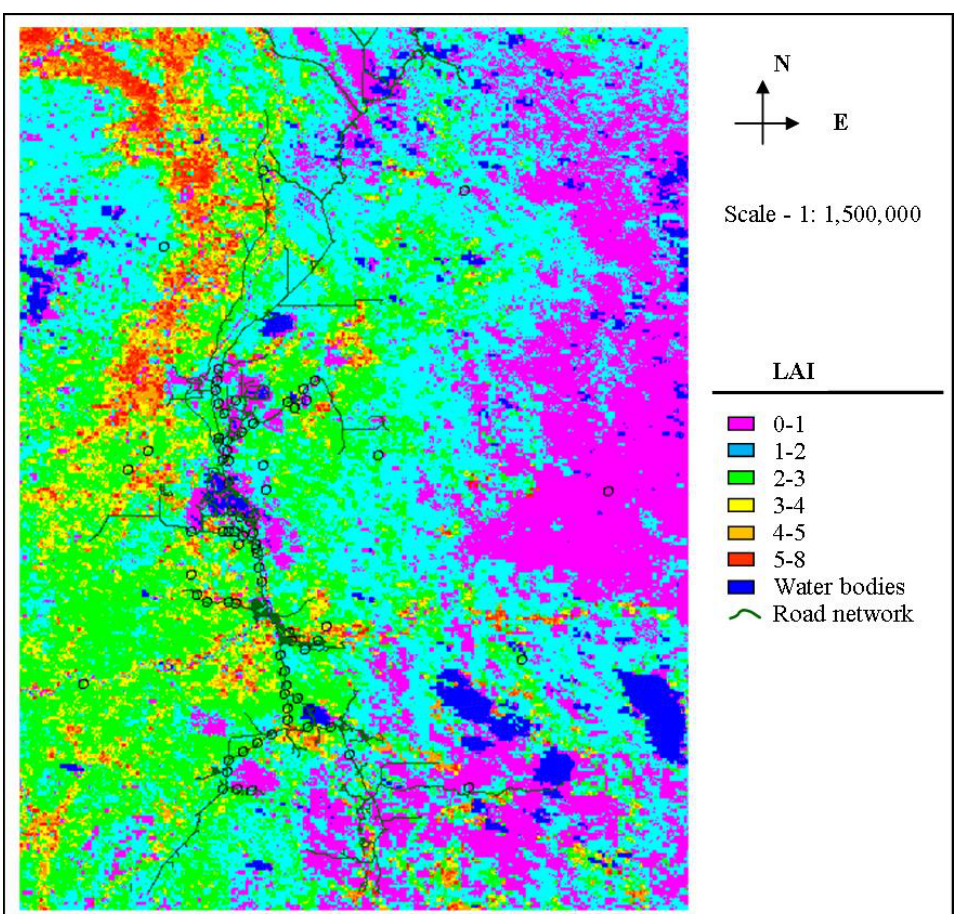
Figure 7. Spatial distribution of LAI for an 8-day period in June 2009 (DOY 169–176) at 250-m resolution for the Athabasca Oil Sands Region (red box in Figure 1). Open circles in the centre, along the road network (green lines) and elsewhere in the image, denote the sites where field-based measurements of LAI were